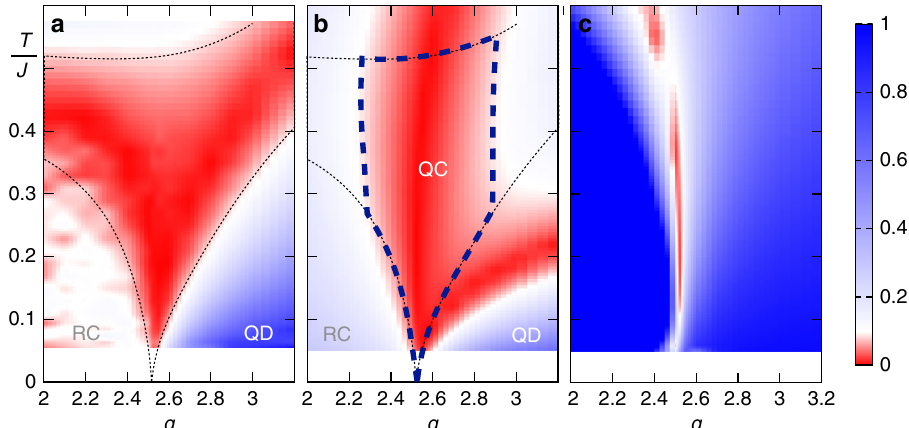
Fig. 4 Reconstruction of the QC fan of the Heisenberg bilayer. ( a ) Relative deviation of the logarithmic derivative of the order-parameter QV from the QC scaling exponent ψ = 0.9625 37 . b Relative deviation of Var prefactor G (Q) (0). Same signi fi cance of line styles as in Fig. 3, and same color scale. Uneven spots in the RC region of ( a ) are numerical artifacts. All data have been obtained on an L × L × 2 lattice with L